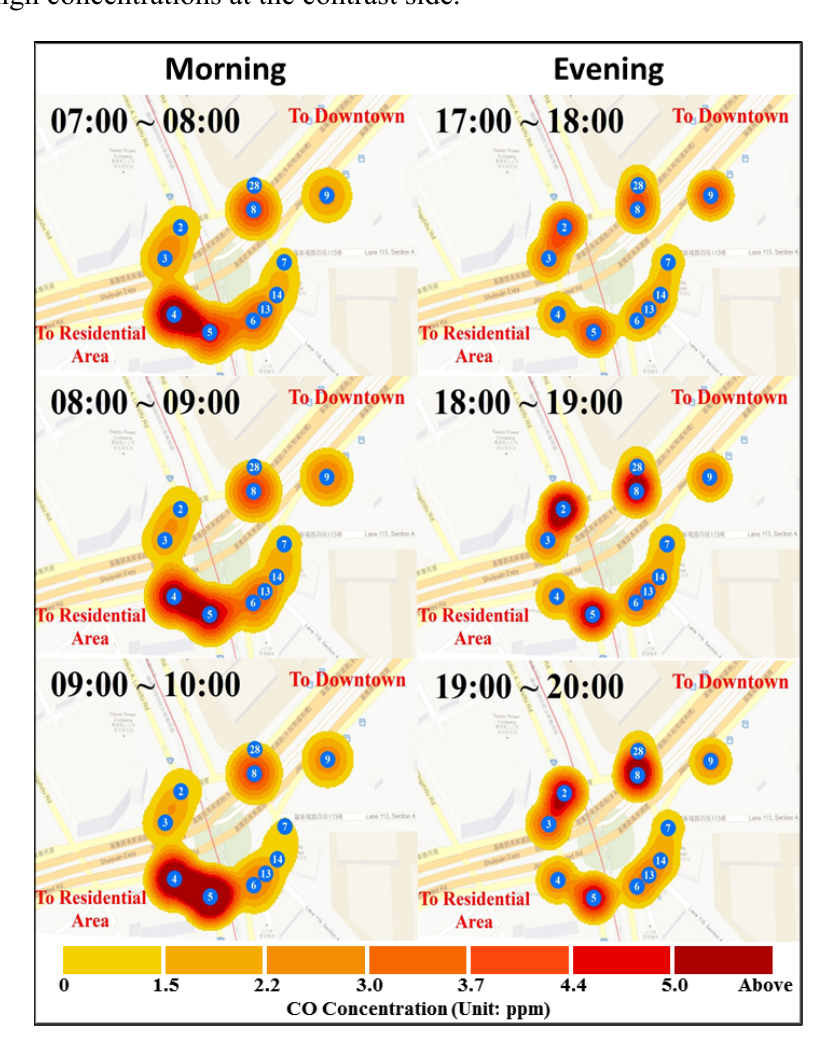
Figure 9. Street-level spatial-temporal variations around the circle: a clear on/off-peak traffic pattern is captured by WSN. In the morning, many vehicles drive from residential to downtown areas for work. This congestion induces a high concentration of air pollutants near a traffic signal. In the evening, the traffic flow to residential areas increases and it results in high concentrations at the contrast